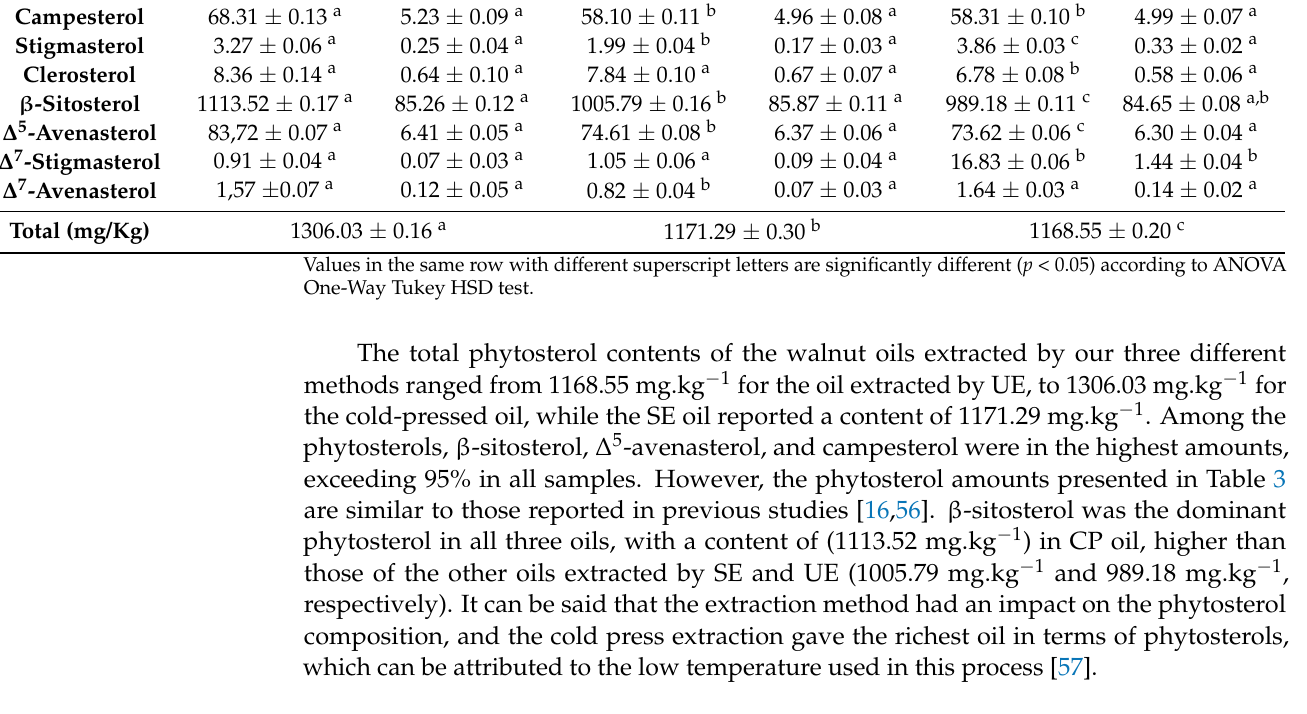
Table 3. Phytosterol Compositions (mg/kg and %) of Oil Extracted from Walnut Samples (Mean ± SE). CP SE UE mg/kg % mg/kg